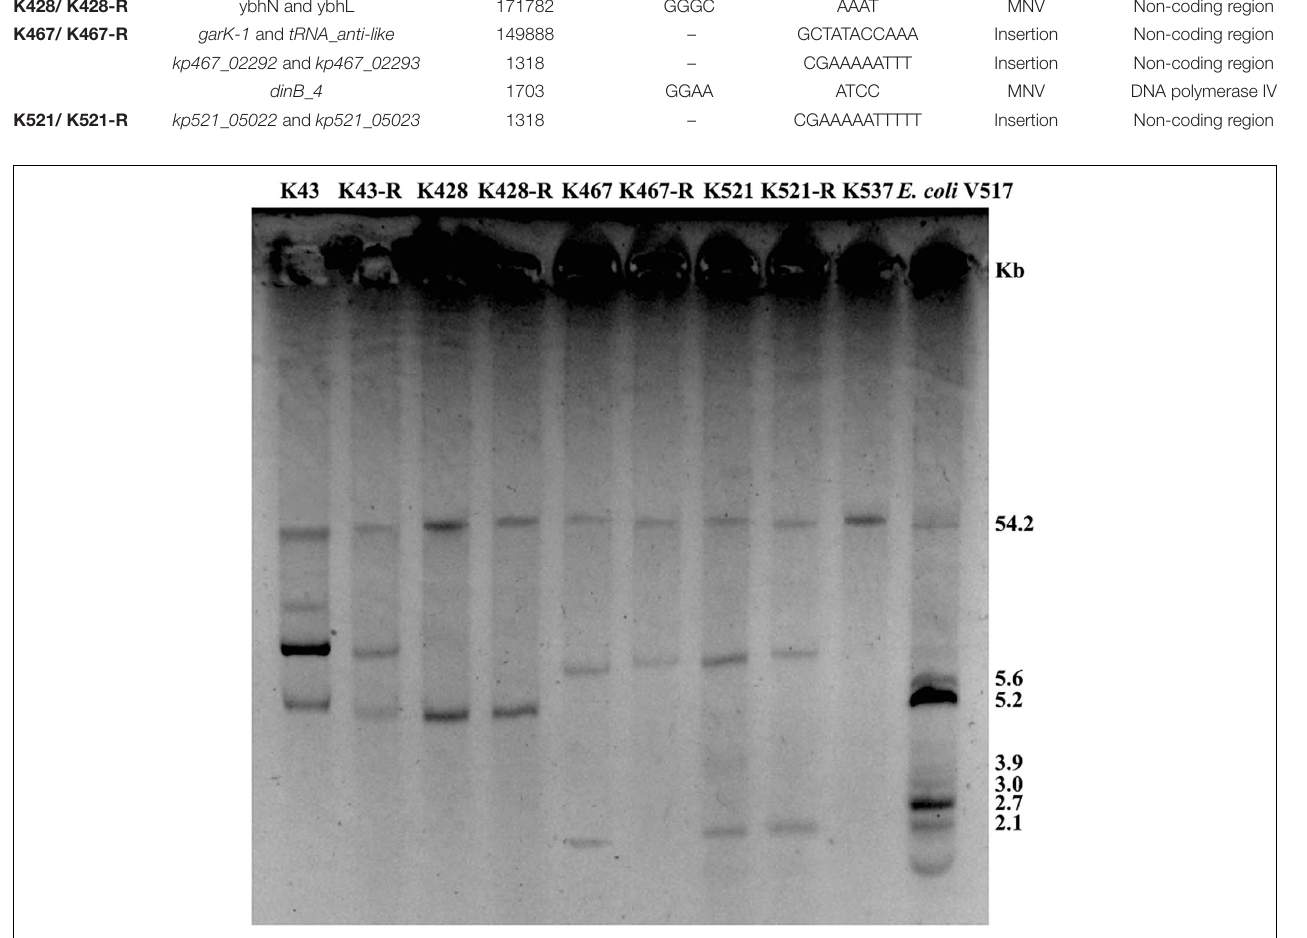
FIGURE 4 | Plasmid analysis of five CRKP clinical isolates and four resistance-induced strains. Escherichia coli V517 was used as a control.